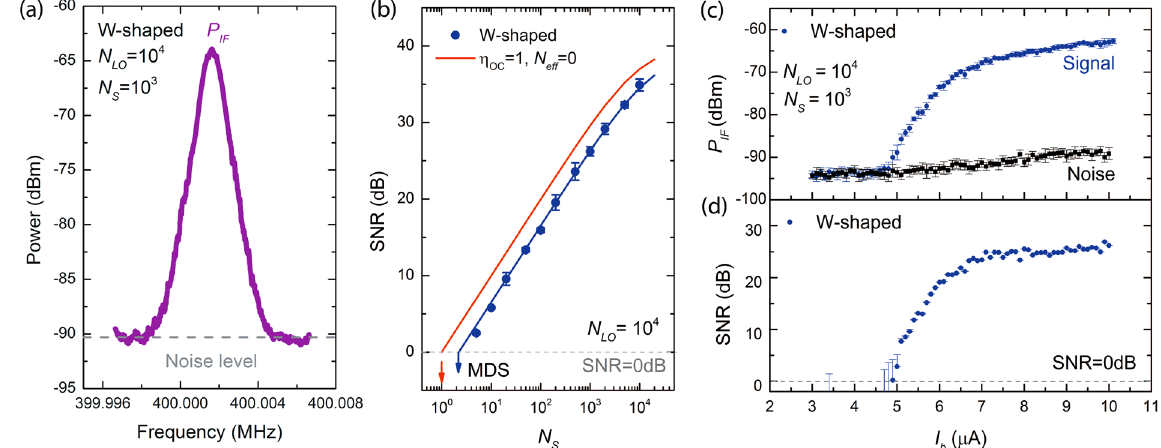
Figure 4. Measurement of the SNSPD performance as coherent detector. ( a ) Measured power vs frequency in the frequency range of f IF ± 5 kHz. ( b ) Measured SNR vs different signal N S at fixed N LO = 10 4 (blue dots). The red line indicates the simulated curve for an ideal shot-noise limited photodetector. The arrows indicate the N S when SNR = 0 dB. ( с ) IF power for signal and noise vs bias current. ( d ) Extrapolated SNR vs bias